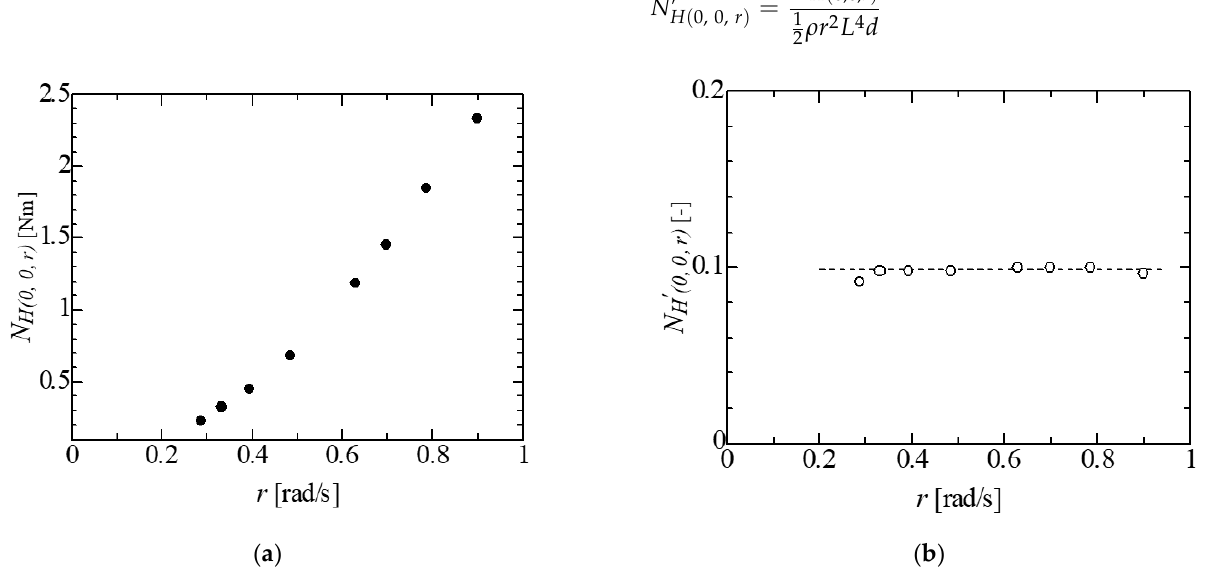
Figure 11. ( a ) Variation of the yaw moment due to static rotation motion along the z -axis with the yaw rate; ( b ) Yaw moment coefficient.